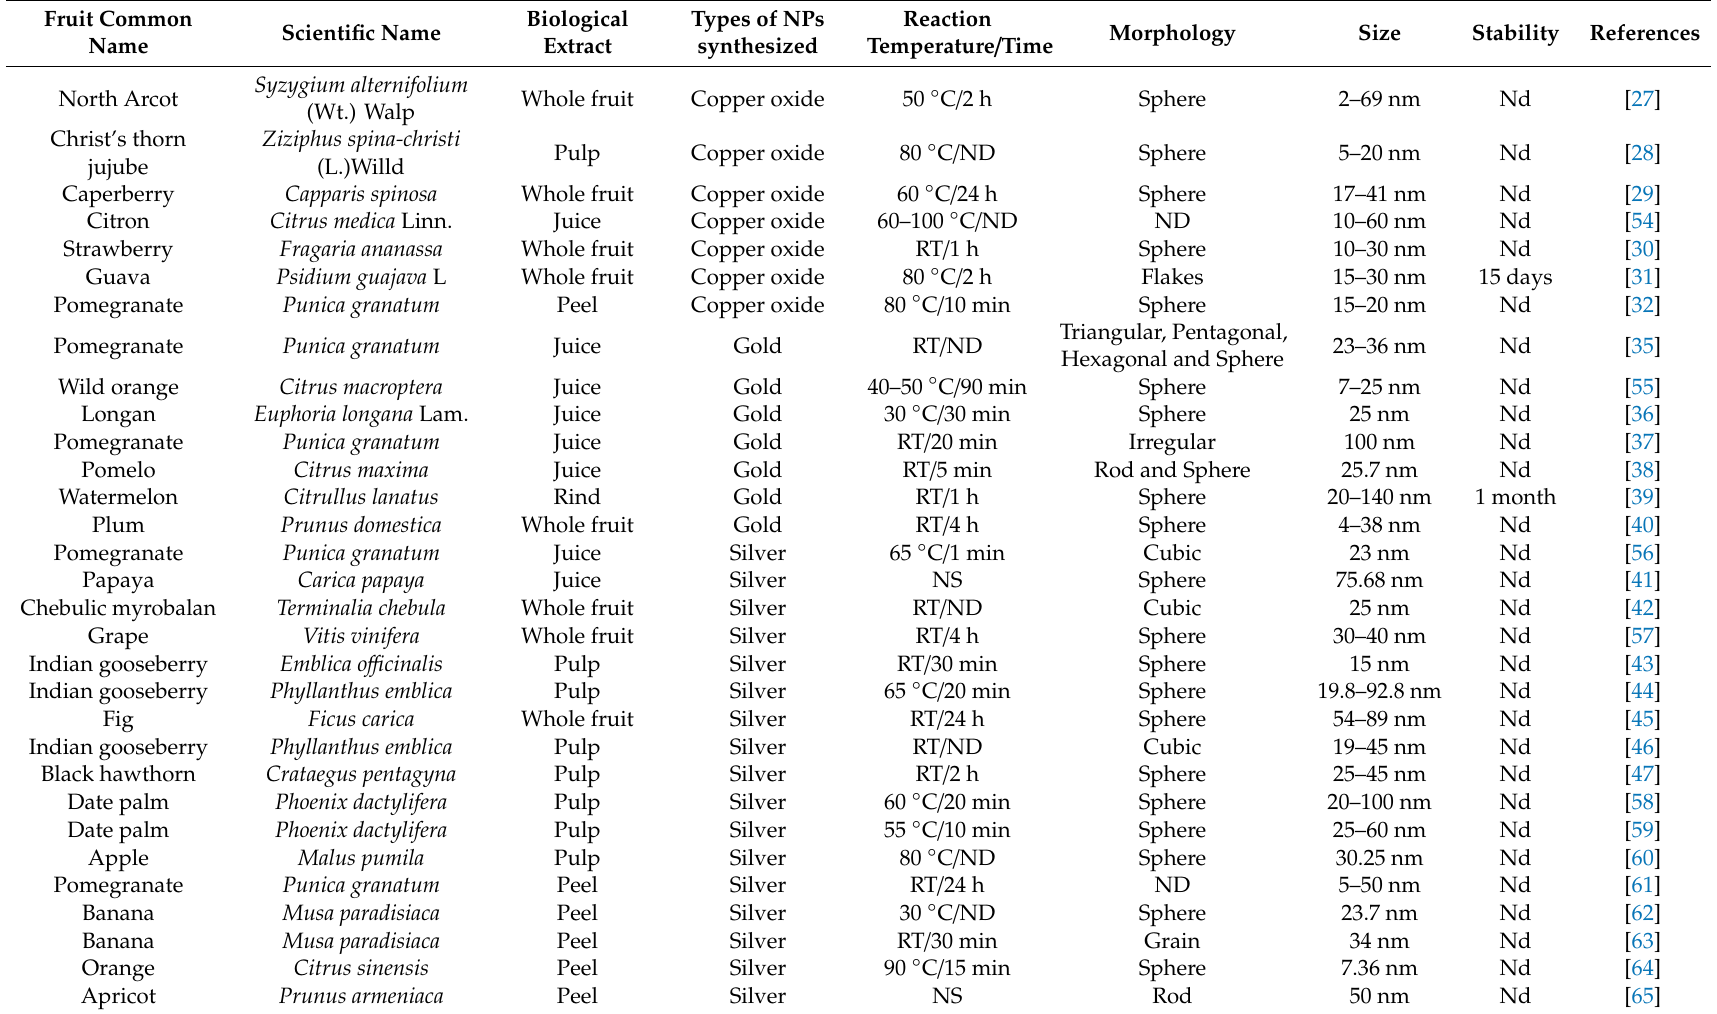
Table 2. Synthesis of nanoparticles (NPs) from various fruit verities.